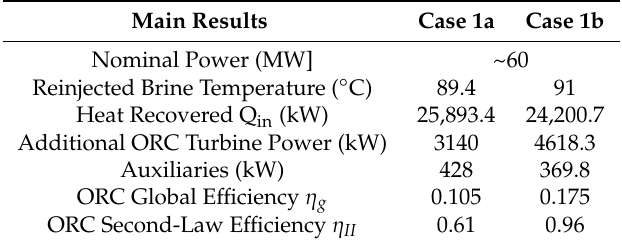
Figure 8. Temperature–enthalpy diagram of the waste heat recovery for the case study 1b, Piancastagnaio. Table 3. Results of the process basic design–energy recovery for case studies 1a and 1b.